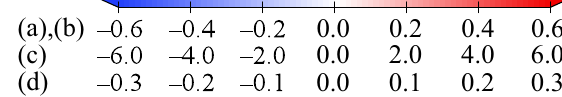
Figure 11. Simulated spatial distributions of 2-day average sedi- mentation rates of suspended matter for events of (a) spring tide (11–12 May 2011), (b) neap tide (18–19 May 2011), and (c) strong wind (30–31 May 2011). (d) Long-term average sedimentation rates of suspended matter from July through December 2011. Black star indicates location of 1FNPP. Contours show water depth (m) ac- cording to JTOPO30